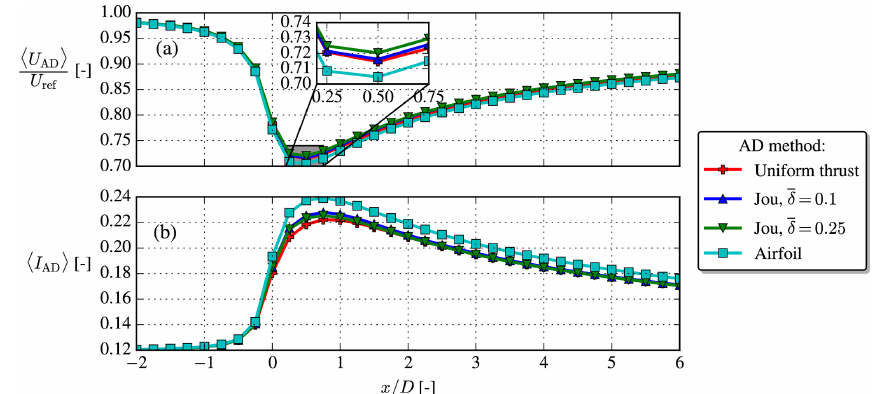
Figure A3. Disk average of velocity, (cid:104) U AD (cid:105) , and disk average of turbulence intensity, (cid:104) I AD (cid:105) .